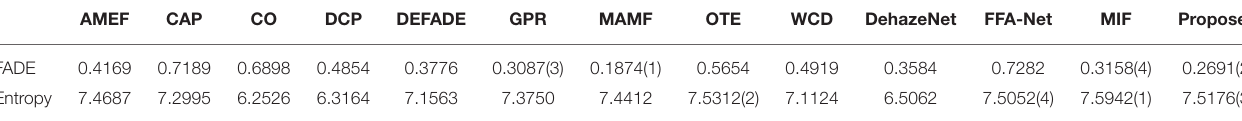
TABLE 3 | Evaluation of two objective indexes in the synthetic driving image ( Figure 7 ) defogging experiment. AMEF Proposed SSIM 0.8037 PSNR 29.198